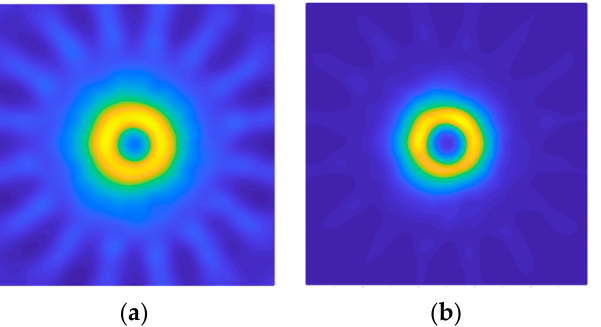
Figure 7. Obtained images for the measurement with the metallic cylinder: ( a ) DAS; ( b ) DMAS.